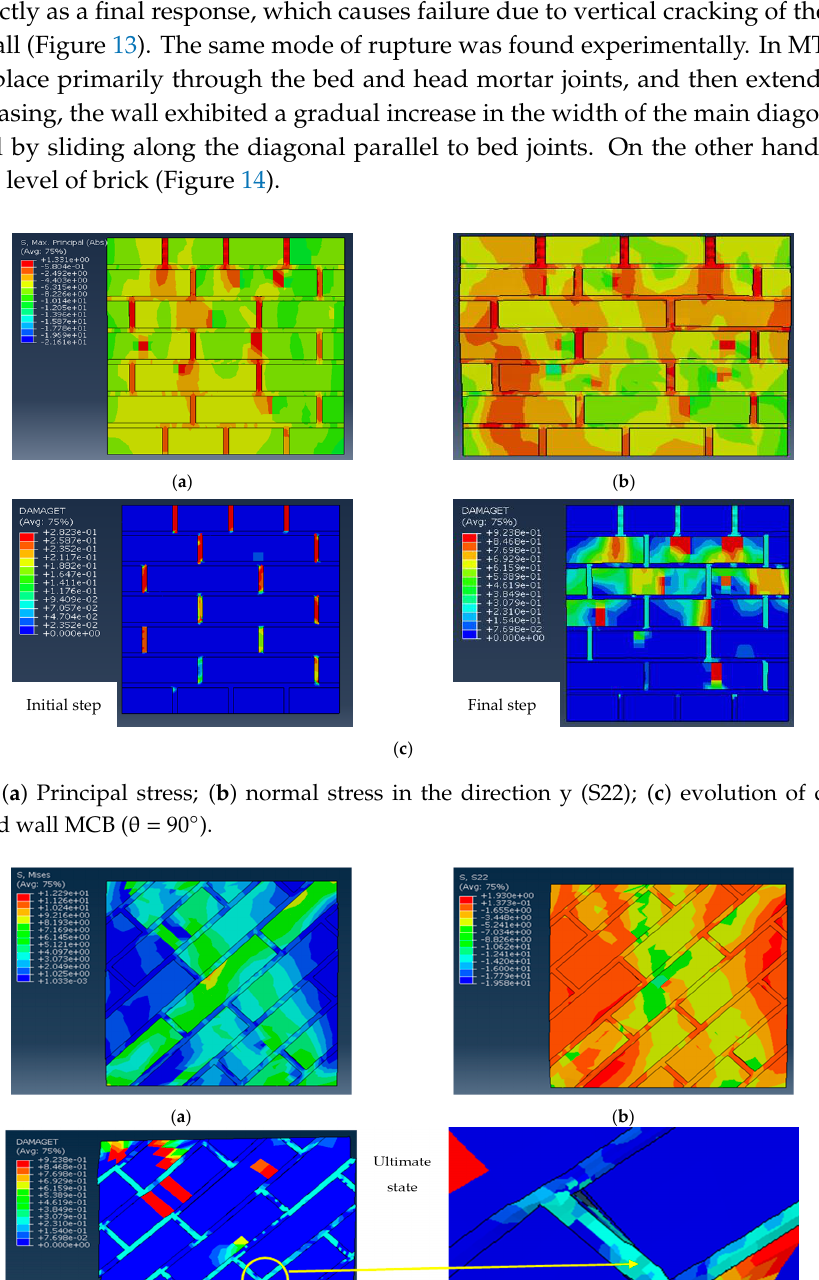
Figure 12. Experimental and numerical curves of stress–strain relationship of unreinforced walls. Table 11. Comparison of numerical result with experimental data.